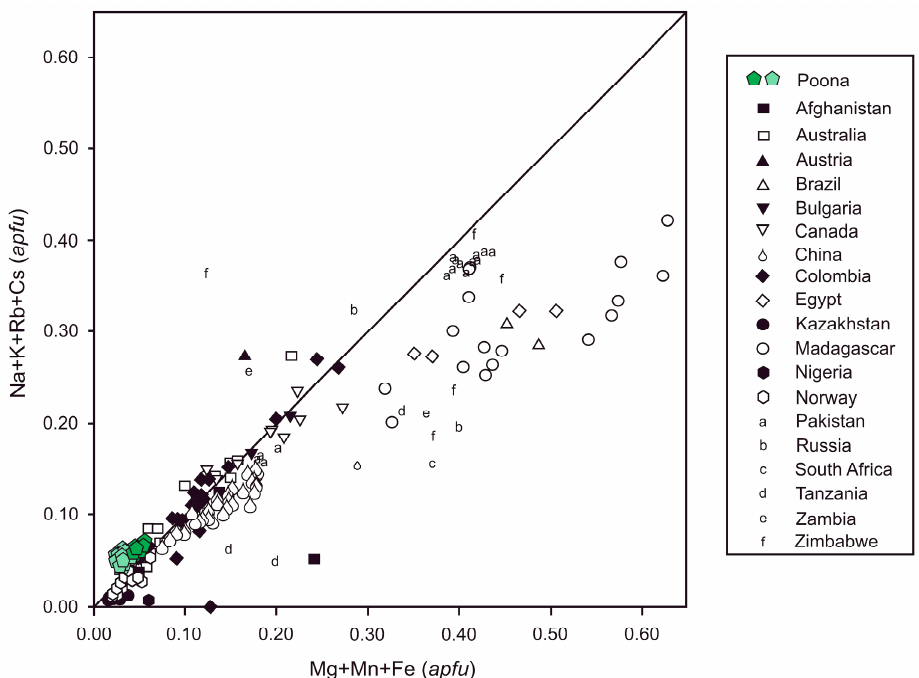
Figure 6. Mg + Mn + Fe versus monovalent channel-site cations, in atoms per formula unit. The Poona compositions (dark and light green hexagons) are superimposed on worldwide emerald data compiled from the literature in [6,7,25,27].